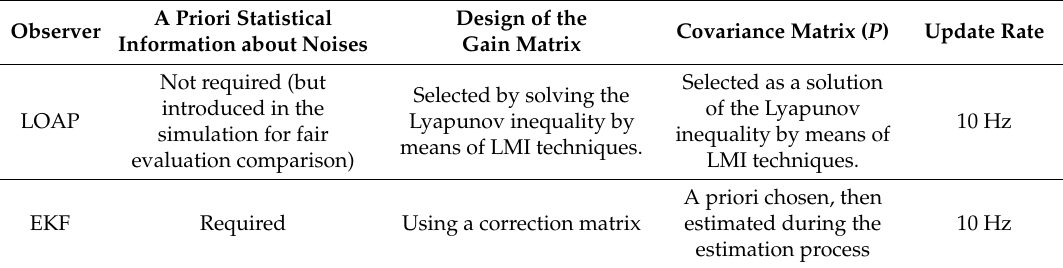
Table 2. A comparison factors of the filters used in this